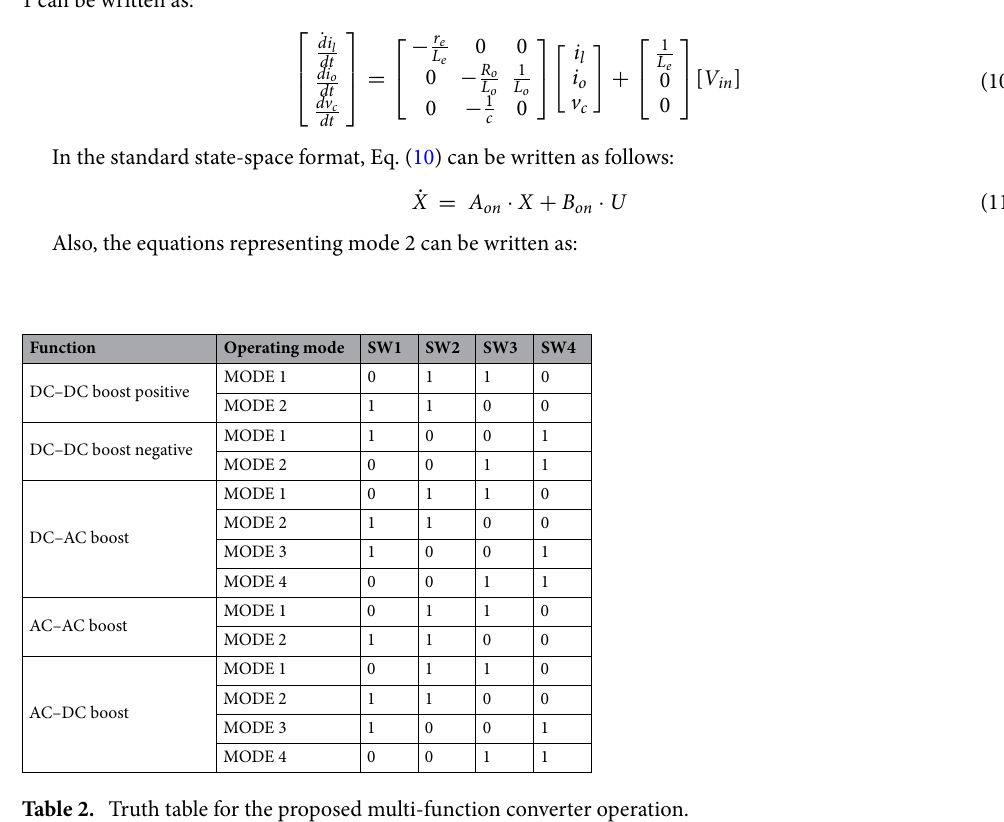
Table 2. Truth table for the proposed multi-function converter